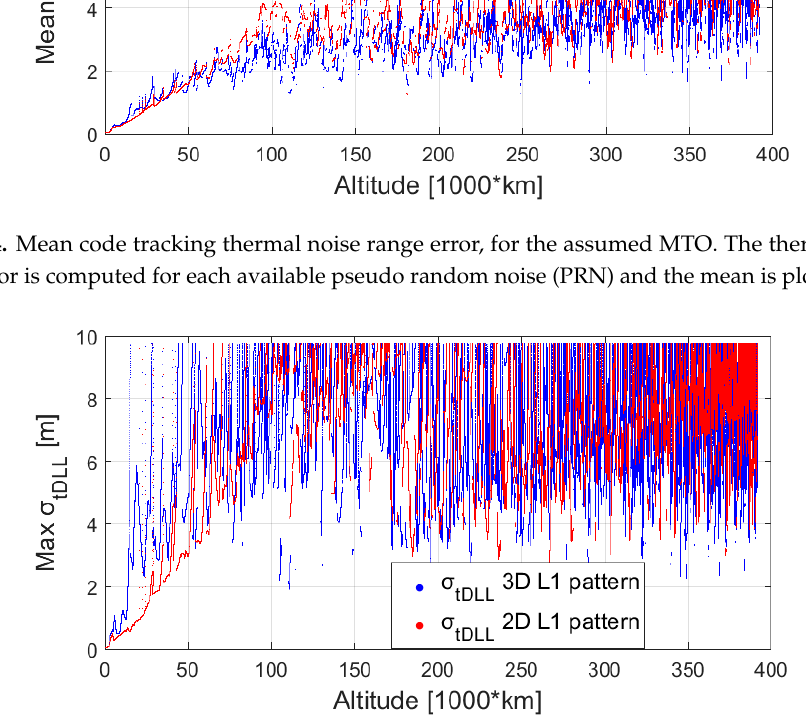
Figure 15. Max code tracking thermal noise range error, for the assumed MTO. The thermal noise range error is computed for each available PRN and the max is plotted.